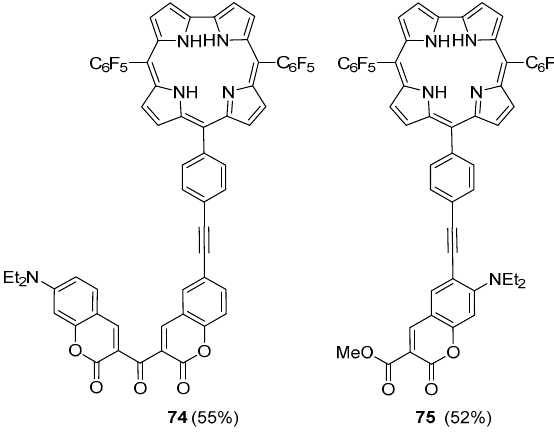
Figure 4. Coumarin–corrole dyads obtained under copper-free Sonogashira conditions [113].